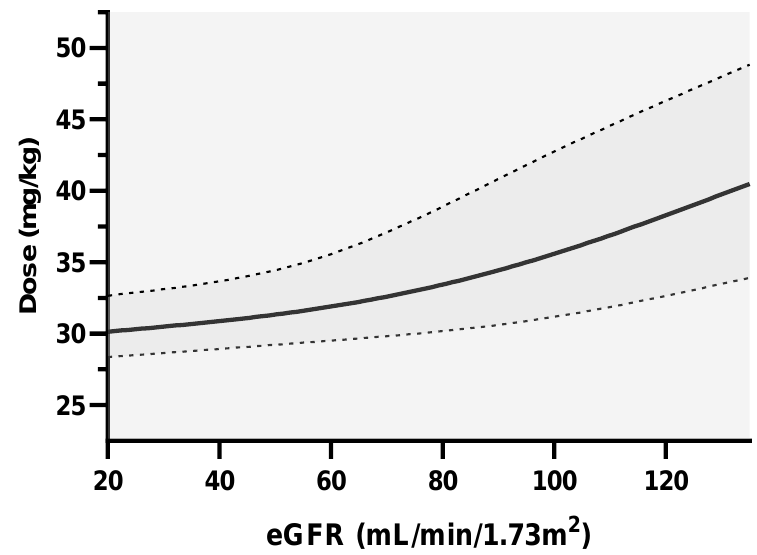
Figure 4. Nomogram of the median first dose of amikacin to be administered to attain a C 1h ≥ 64 mg/L in 90% of the studied population for a TBW of 76.5 kg (median value of the studied population, full line), a TBW of 52 kg (10th percentile, top dashed line), and a TBW of 125 kg (90th percentile, bottom dashed line).